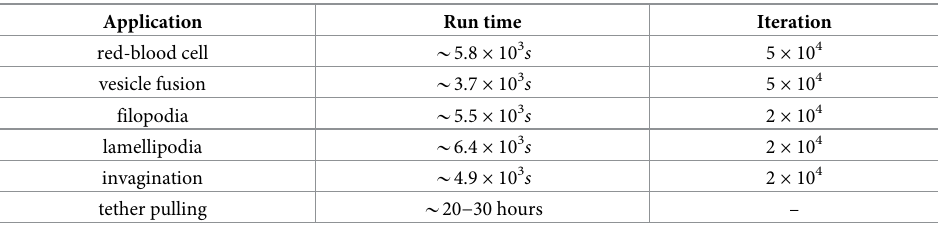
Table 2. Computational